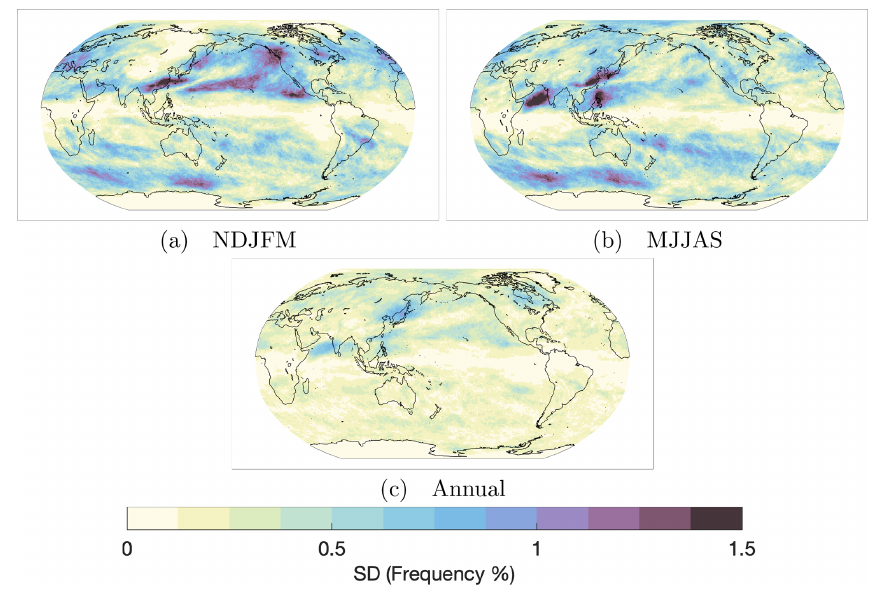
Figure 3. The historical E3SM five-member ensemble standard deviation (SD) of AR frequencies for the (a) winter, (b) summer, and (c) annual periods.